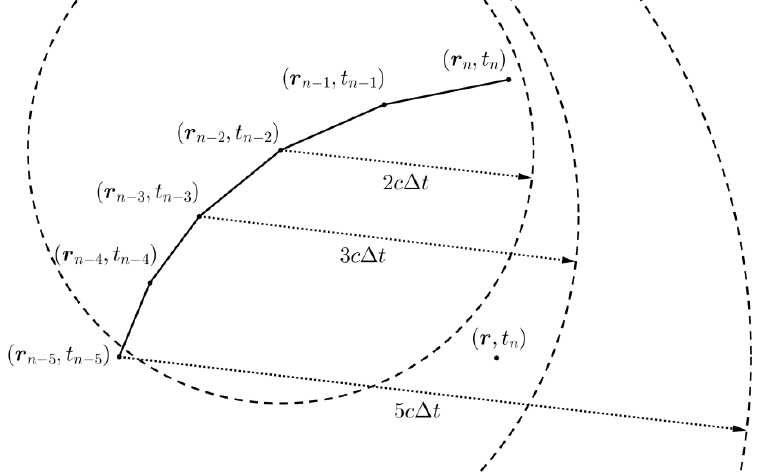
Fig. 2. The bisection method for searching the time moment in the past. First, we construct the first sphere for the maximum moment in the past when the particle appeared in the interaction space - in this case, a sphere of radius 5сΔ t for n - 5 step. Then we divide the number 5 by 2 in order to build the next sphere with radius 2сΔt, for step n - 2. We find the sphere lying between them for (5 + 2) / 2 = 3, n - 3 step . We continue the process until the radii of the spheres differ by cΔt. In the latter case, the process is terminated. Due to the peculiarities of modeling, in the past, we take the moment in the time corresponding to the sphere with larger radius - in this case, n -